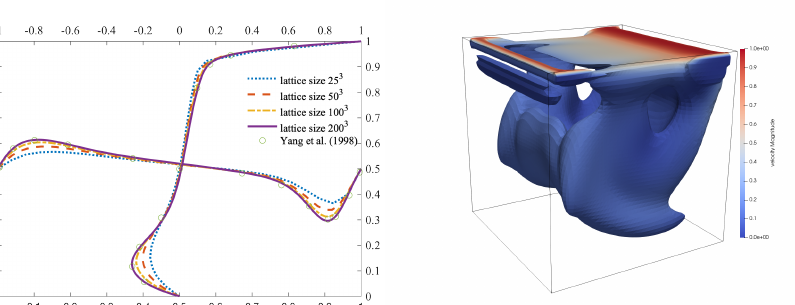
Figure 2. Lid-driven cavity flow for Re = 1000. Left : velocity profiles on the mid-plane y = 0.5 with mesh refinement with reference data [38]. Right : Iso-surface of Q-criterion of the velocity field for the lattice size 50 3 visualised in